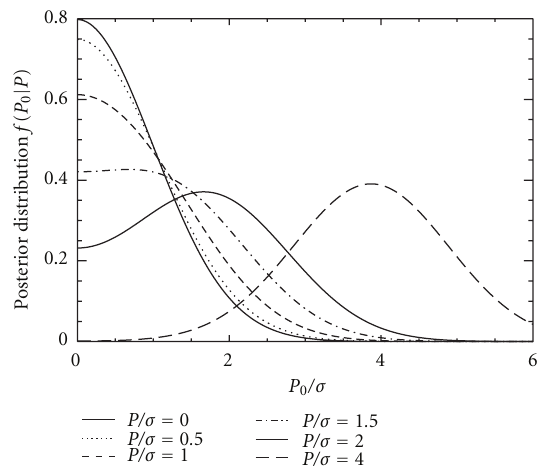
Figure 1: Posterior distribution function from the Rician distribu- tion and for the case of a single polarisation measurement, from (7). Note that for measured polarisation values P/σ < distribution (as a function of the true polarisation, P 0 /σ ) peaks at zero